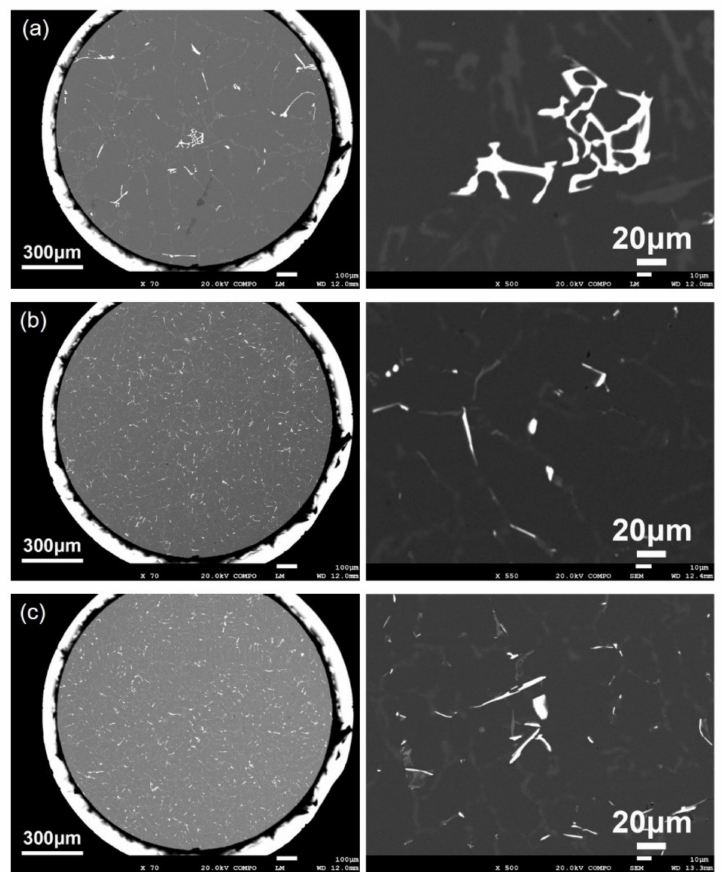
Figure 7. SEM microstructure showing the morphology of La-rich phases. ( a ) 0.2, ( b ) 1.5, ( c ) 9 K / s.